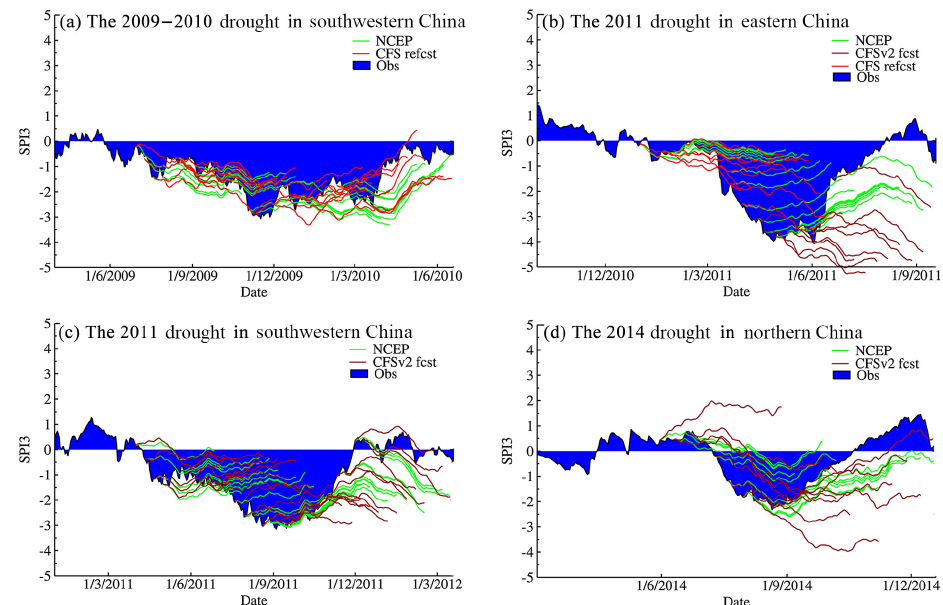
Figure 12. Simulation and prediction results of four recent severe drought processes in China. Every unfilled curve represents simulated or predicted prospective 90-day SPI3, with an interval of initial prediction time of about 10 days. The curves filled with blue refer to observed SPI3. Dark red and bright red curves refer to SPI3 predicted with CFSv2 and CFS products, respectively. Light green curves represent SPI3 simulated with the NCEP/NCAR reanalysis datasets. Every simulated or predicted curve consists of daily SPI3 time series with 90 points. ”Reforecast” is denoted by ”refcst”.